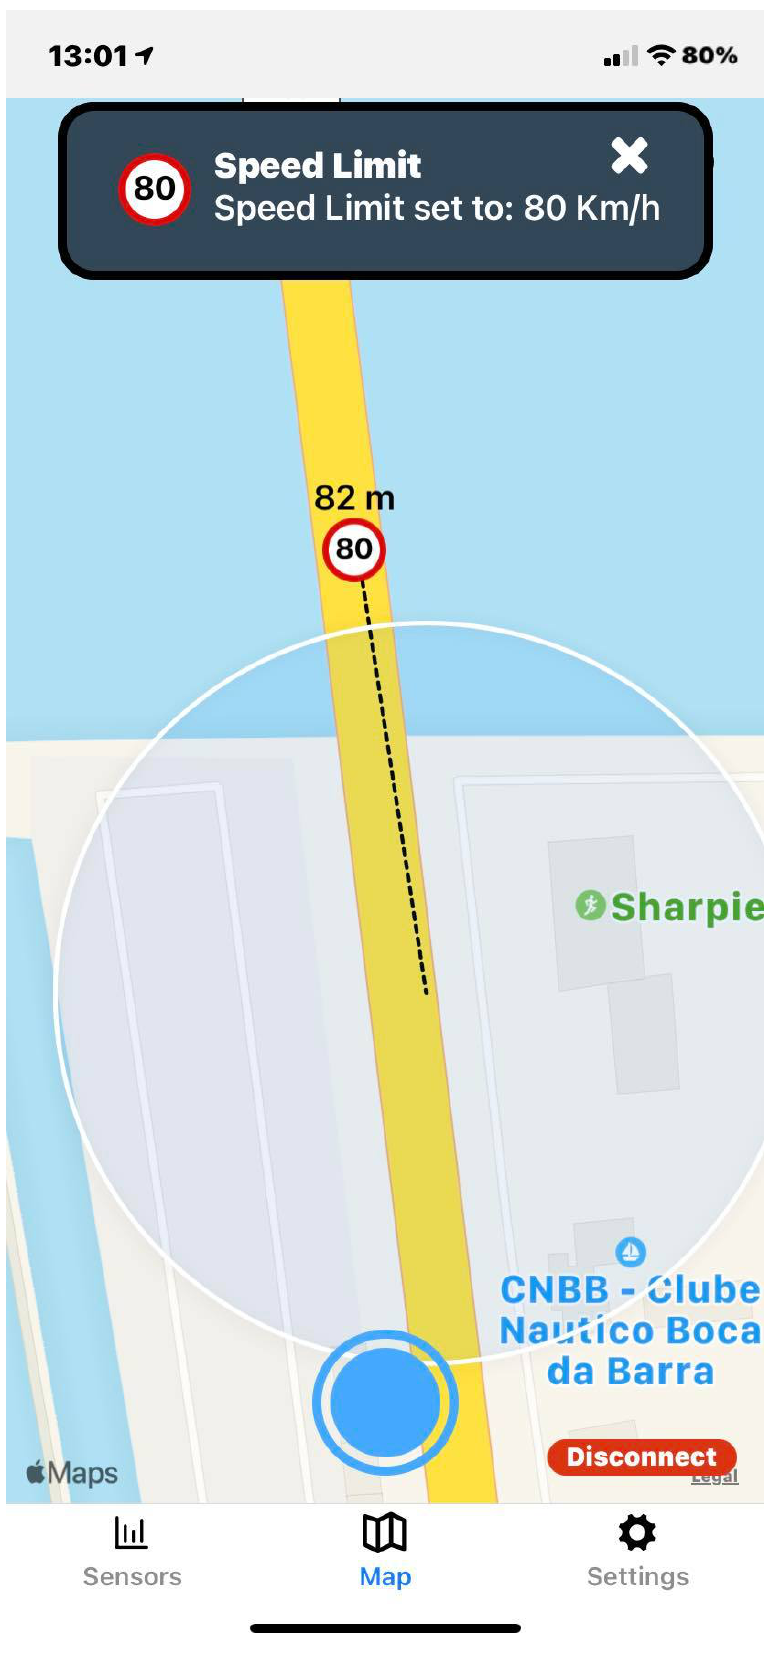
Figure 9. IVIM message representation in the mobile